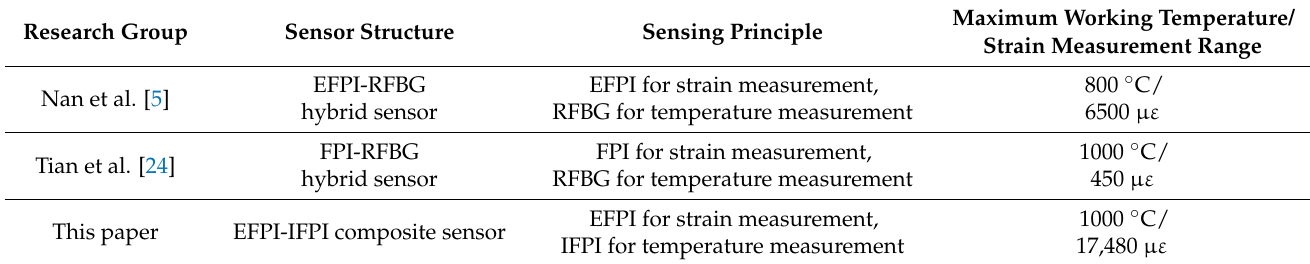
Table 1. A few types of FPI-based composite sensors for temperature-strain measurement under high temperatures. Research